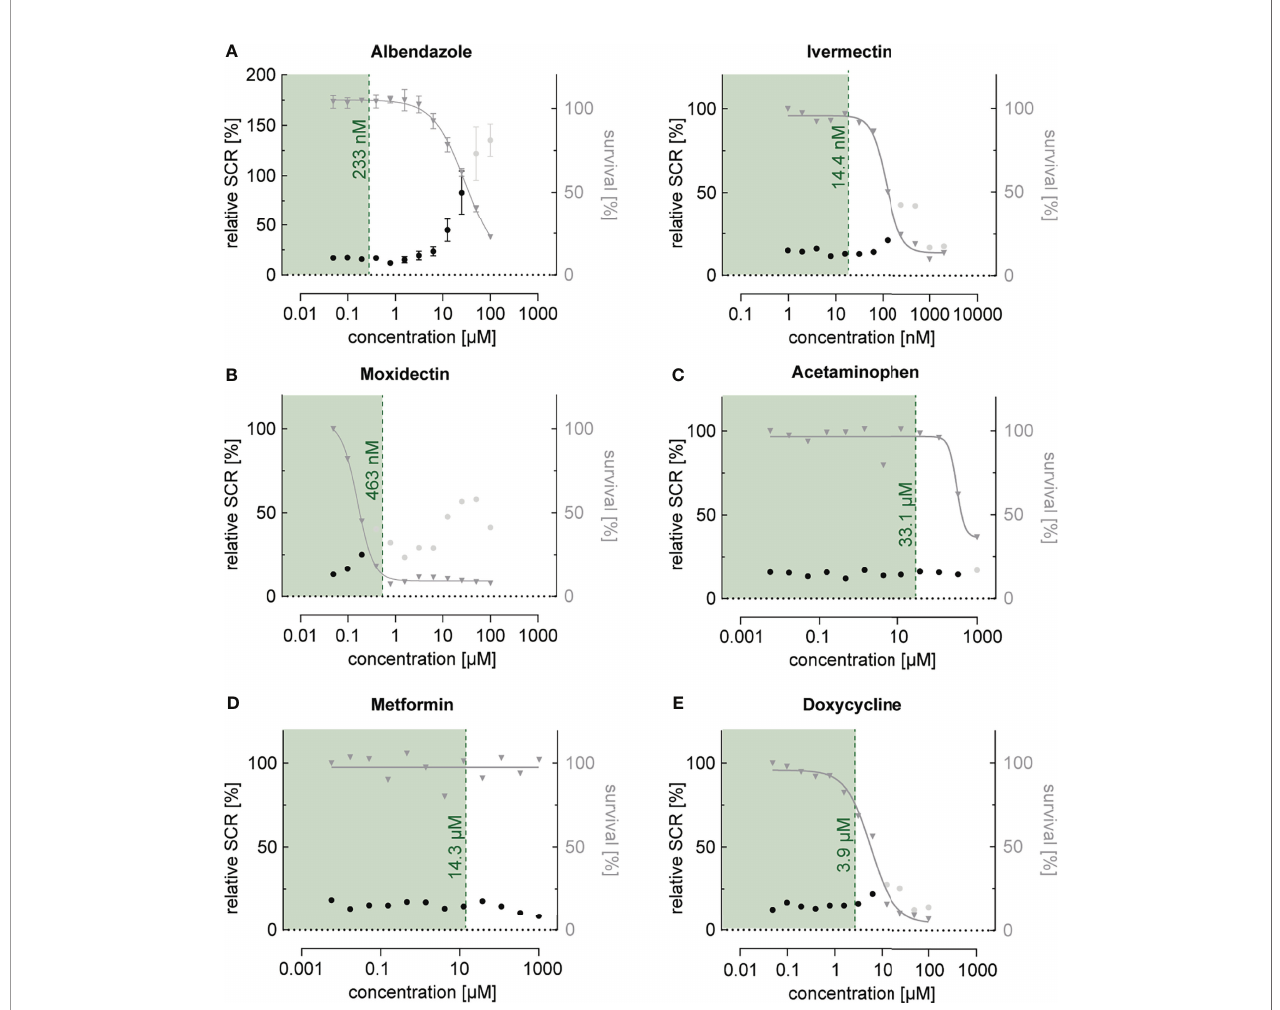
FIGURE 4 | Dose-response relationship between commonly used drugs and parasite sexual commitment. (A) The antihelminthics albendazole and ivermectin show a general trend towards induction of sexual commitment at super-physiological concentrations that also affect parasite growth (see also Figure S4 ). (B) The antihelminthic moxidectin affects parasite growth as well as SCRs at physiological concentrations. (C – E) The commonly used drugs acetaminophen (antipyretic) (C) , metformin (antidiabetic) (D) and doxycycline (antibiotic) (E) have no effect on parasite growth or SCRs at physiologically relevant concentrations. Mean parasite survival rates and SCRs are indicated by grey triangles and black bullets, respectively. Grey bullets represent SCRs at compound concentrations above the IC50. The maximum physiological concentrations are indicated in green. Values are normalized to the corresponding control conditions (-SerM for SCR) and (-SerM/choline for survival). Albendazole: n=3; error bars represent the standard error of the mean. Ivermectin, Moxidectin, Acetaminophen, Metformin and Doxycycline: